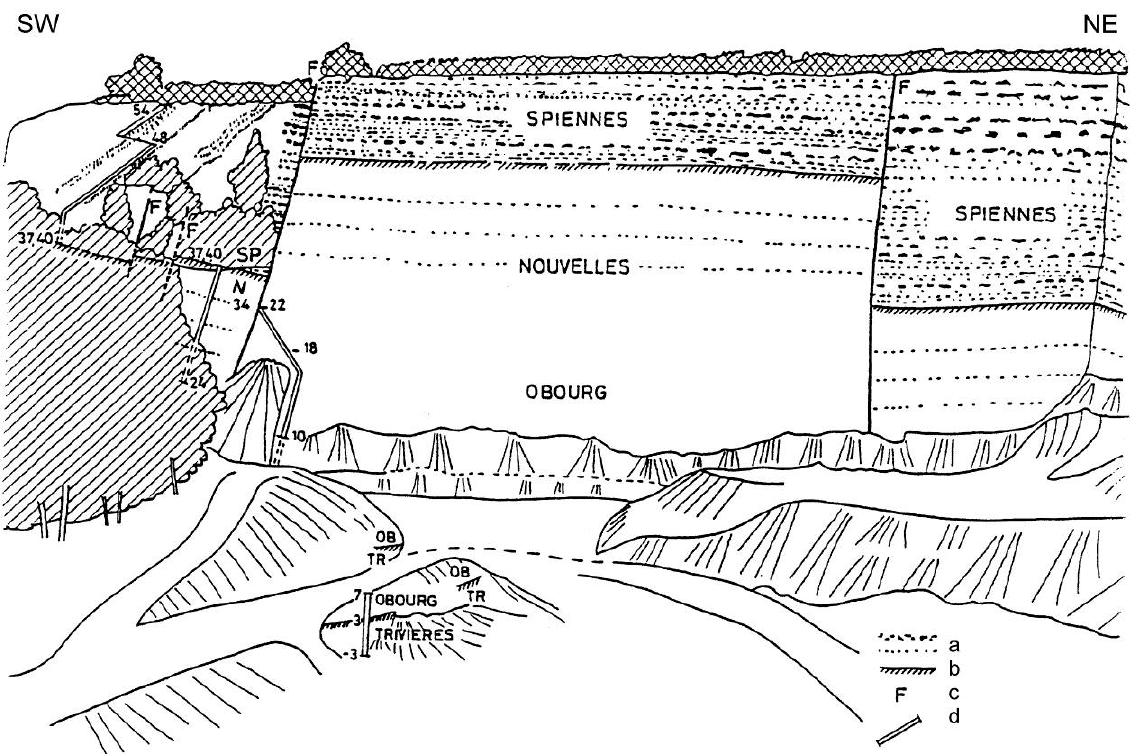
Figure 7. Spiennes. Cross section drawn in the Omya Quarry, at the edge of the Camp-à-Cayaux plateau (Robaszynski & Christensen